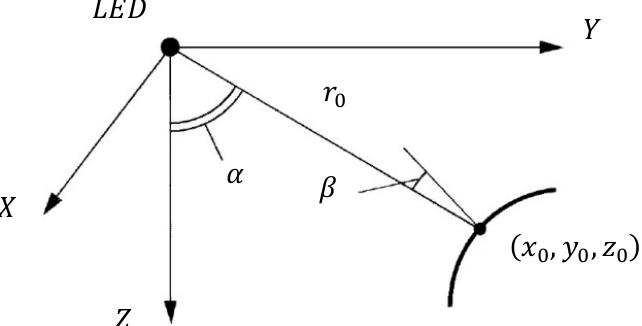
Figure 2. Initial schematics for calculation of illuminance of a single LED point source.